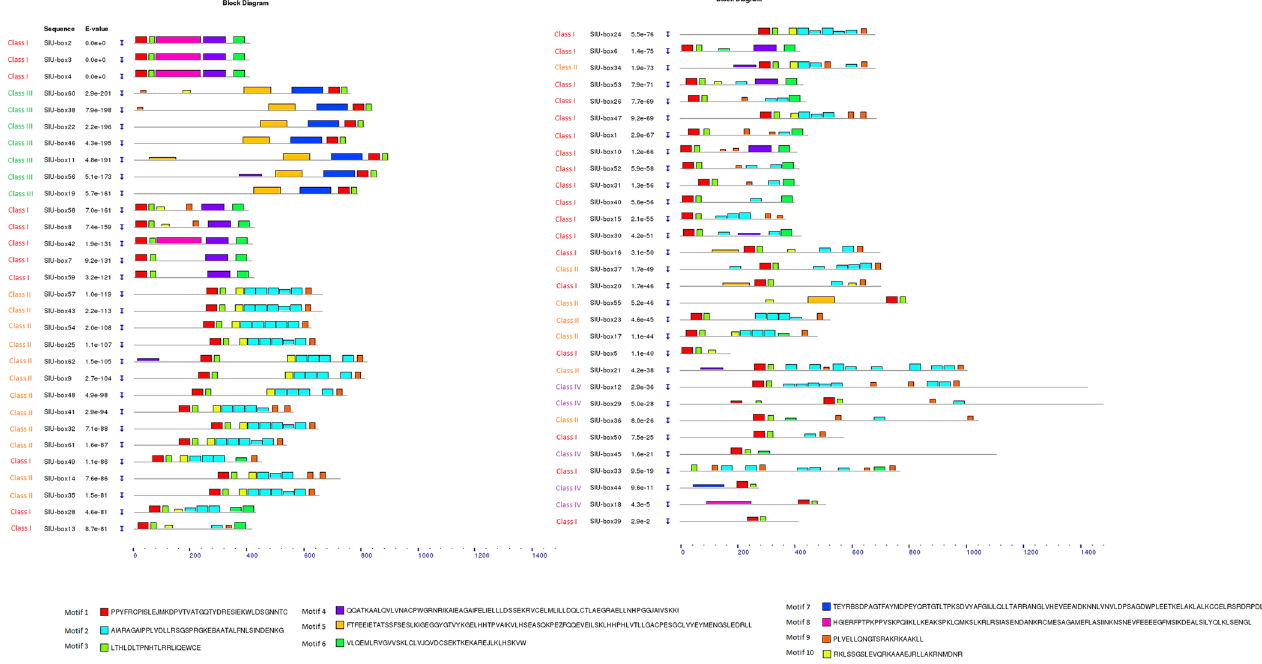
Figure 2. Using MEME suite 10 motifs were discovered in a total of 62 tomato U-box members. Their sequence and organization are represented by different colors.